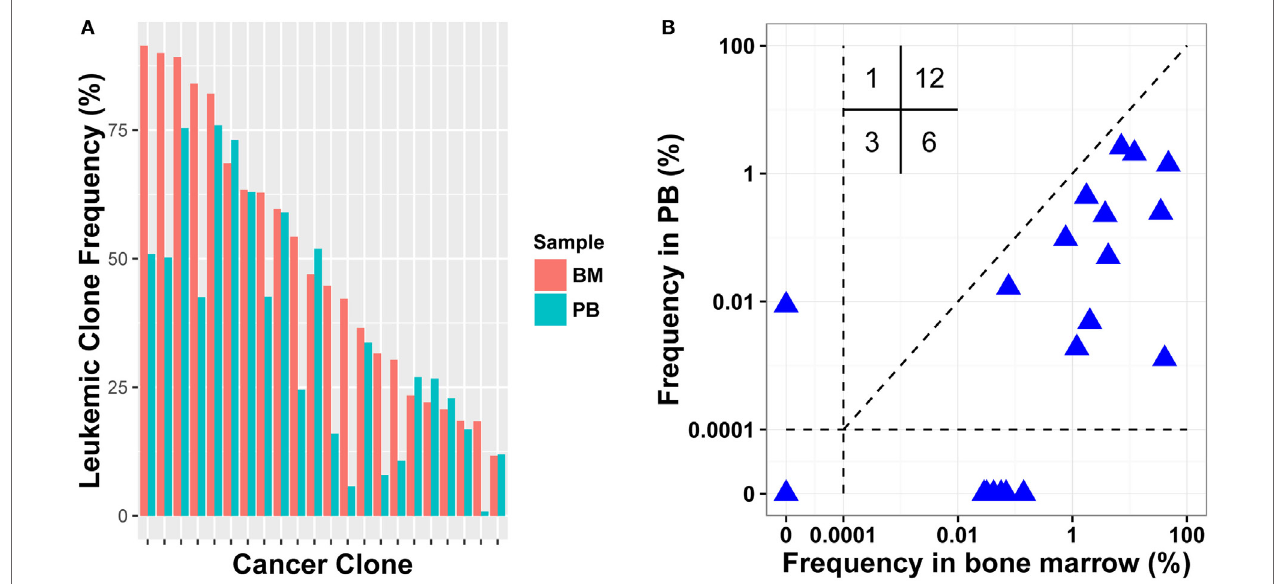
FigUre 3 | comparison leukemic clone frequency between bone marrow (BM) and peripheral blood (PB) specimens for diagnostic (a) and follow-up (B) samples . Values in the up left in (B) represent the number of samples in each